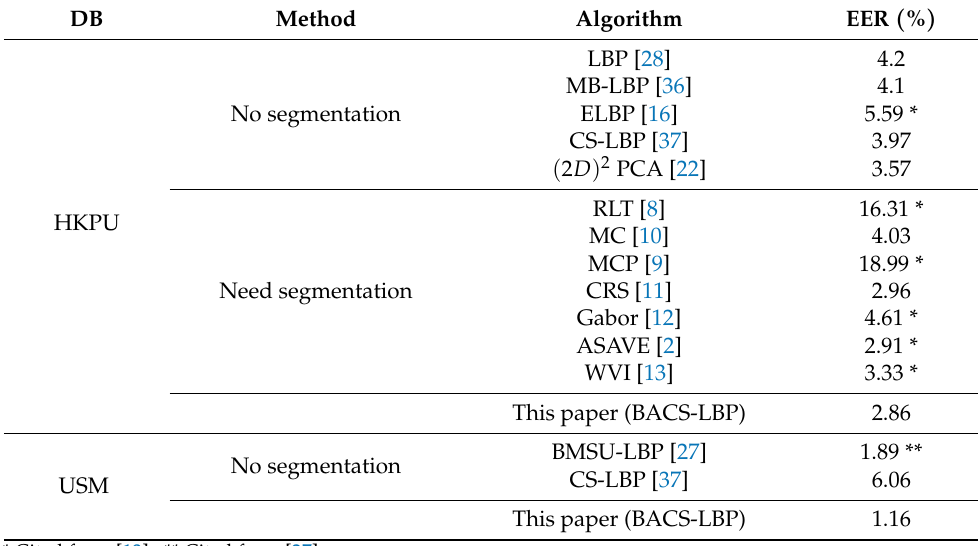
Table 6. Comparison of the recognition performance of our proposed method and existing methods in two